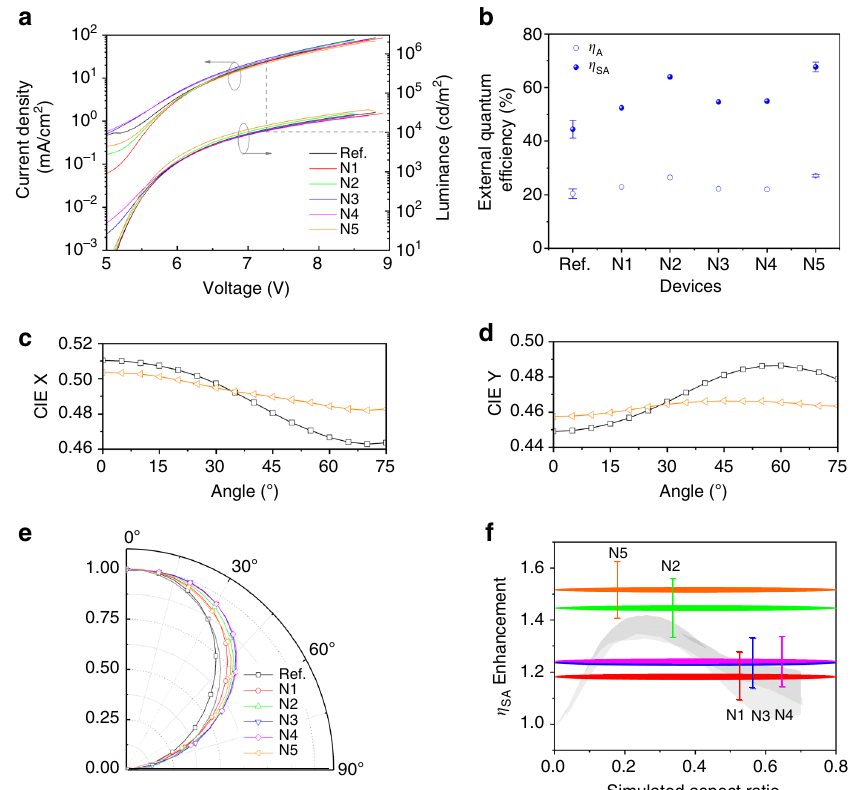
Fig. 6 The performance of white OLEDs based on RIE-induced nanostructures. a Current density – voltage – luminance characteristics. b The η A and η SA at the luminance of 10,000 cd m − 2 . c The angular dependence of CIE x. d The angular dependence of CIE y. e The angular radiant intensity. The gray line is the Lambertian distribution. f Dependence of the η SA enhancement factor on the aspect ratio of sinusoidal nanostructures. The gray band represents the range of simulated enhancement factors (cf. Fig. 5c). The error of η SA enhancement factor is obtained by averaging different devices. The horizontal lines re fl ect the problem to align the complex nanostructures with absolute certainty to the simulated ARs. The presented location refers to the case, where the experimental AR is calculated with the dominant depth h as the AR-de fi ning depth (see Supplementary Note 4 for